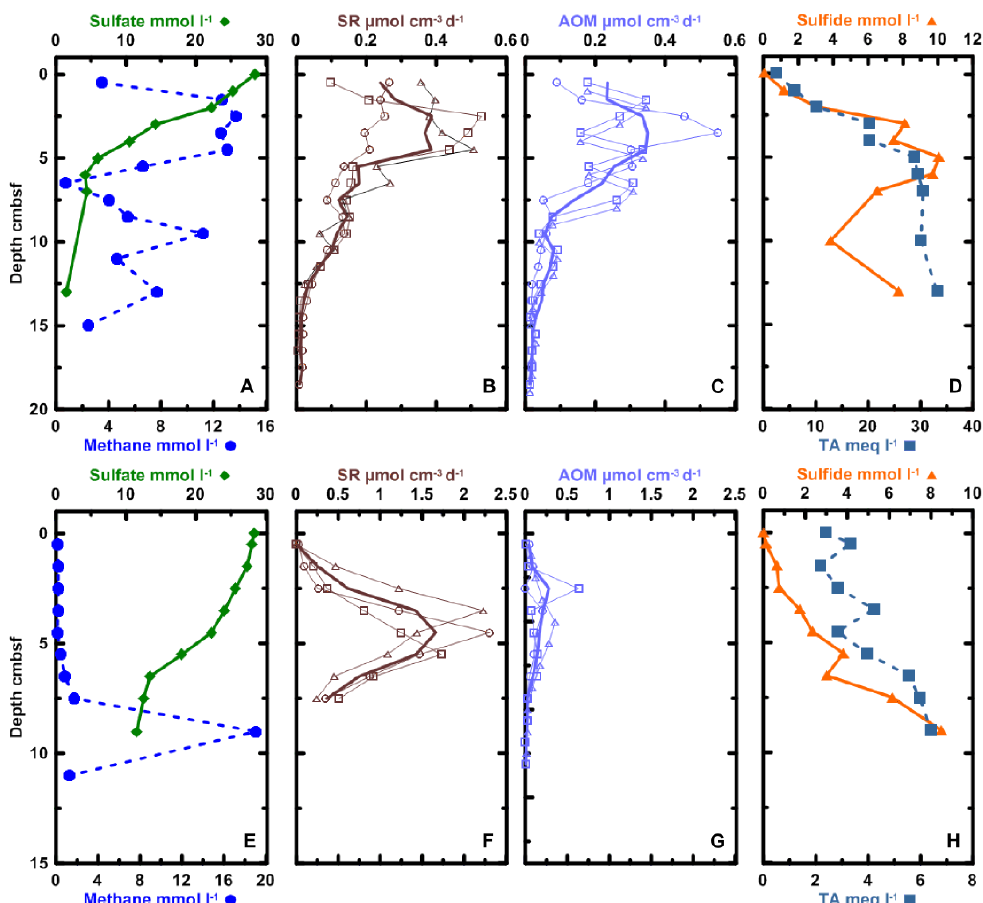
Fig. 4. Mound 12 porewater profiles for sulfate, methane, sulfide, and total alkalinity (TA) as well as sediment rates of sulfate reduction (SR) and anaerobic oxidation of methane (AOM). (A–D) : SO206-44 (MUC) (covered by sulfur bacteria mat); (E–H) : SO206-46 (MUC) cores (covered by bacterial mat). For SR and AOM profiles of individual replicates (fine lines with symbols), average profiles (bold lines without symbols) are